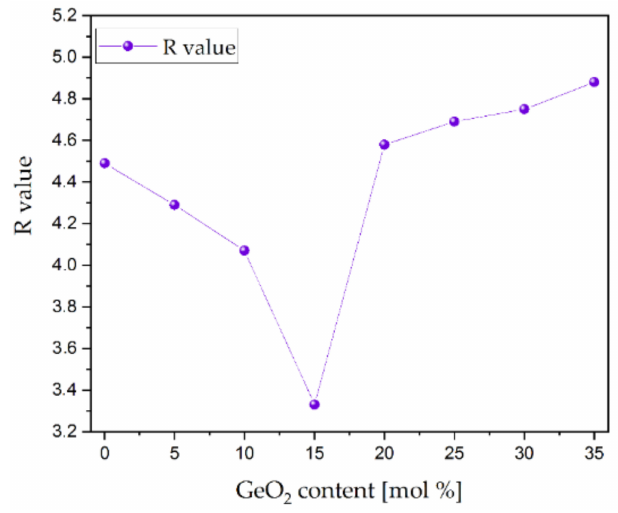
Figure 13. R values vs. GeO 2